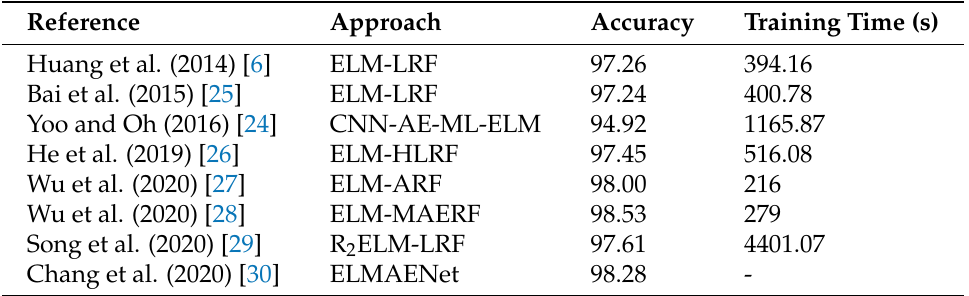
Table 13. The results obtained by CELM architectures for object recognition in the NORB dataset.